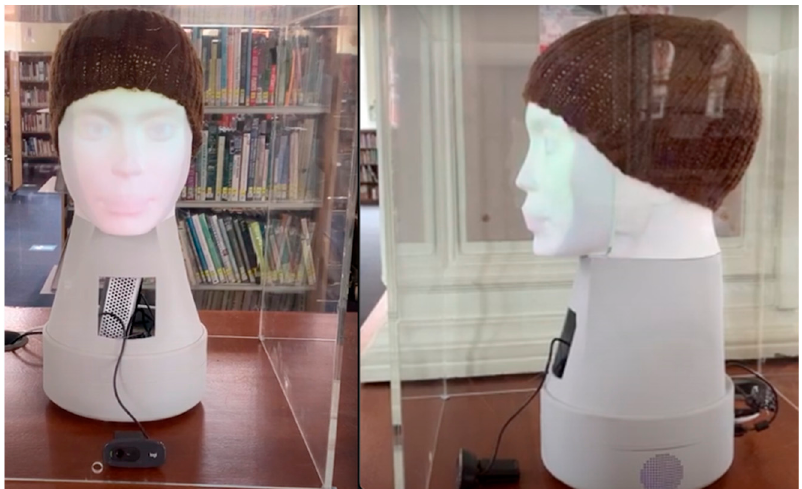
Figure 1. Interactive biomimetic robotic head PLEA during the ART–AI Festival 2021, Leicester, UK.